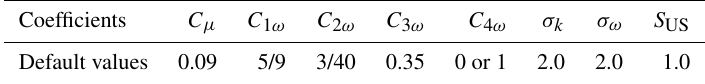
Table 4. Default coefficient values for k − ω model.